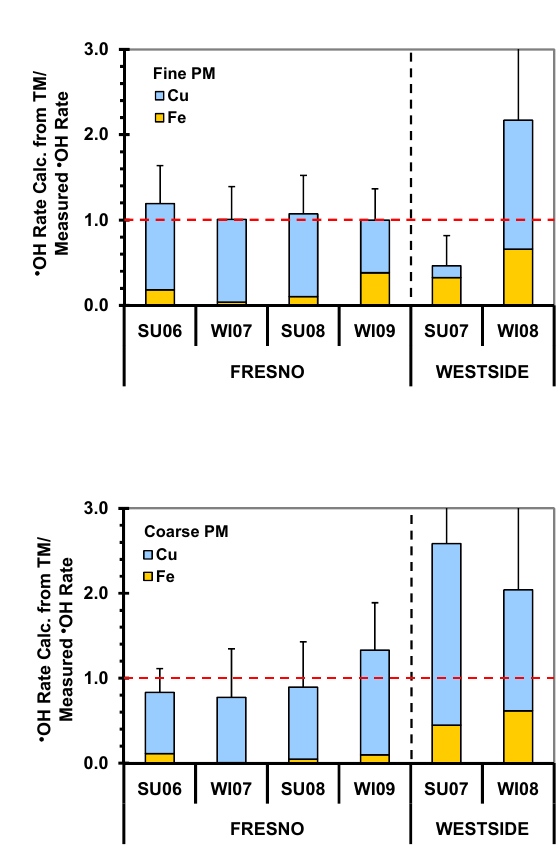
Fig. 9. Contributions of SLF-soluble Cu (blue bars) and Fe (yellow bars) to the initial rate of • OH generation in SLF with Asc in fine (a) and coarse (b) particles. Values are means ± SD, n = 3. There are three samples whose error bars extend beyond the range of the y-axis (mean ± 1SD): Westside winter 2008 fine PM, 2.2 ± 1.9; Westside summer 2007 coarse PM, 2.6 ± 3.1; Westside winter 2008 coarse PM, 2.0 ±